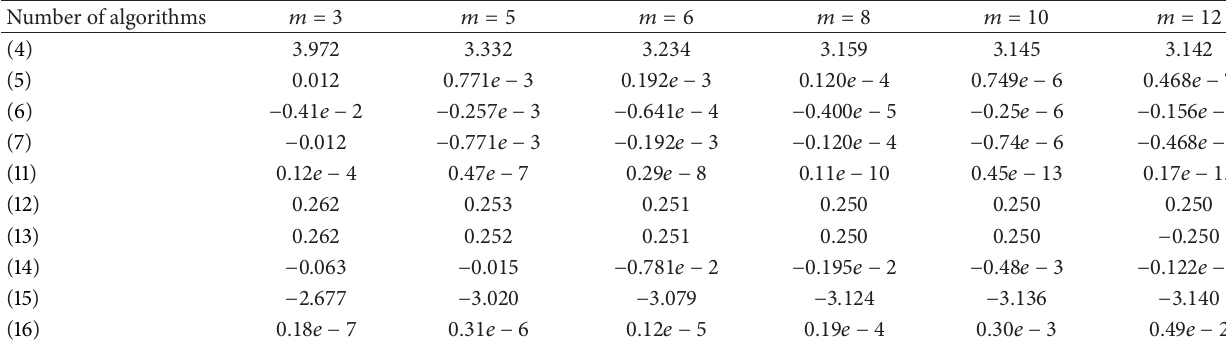
Table 1: Maximum values of the absolute radial error ( 𝑅 = 2 𝑚